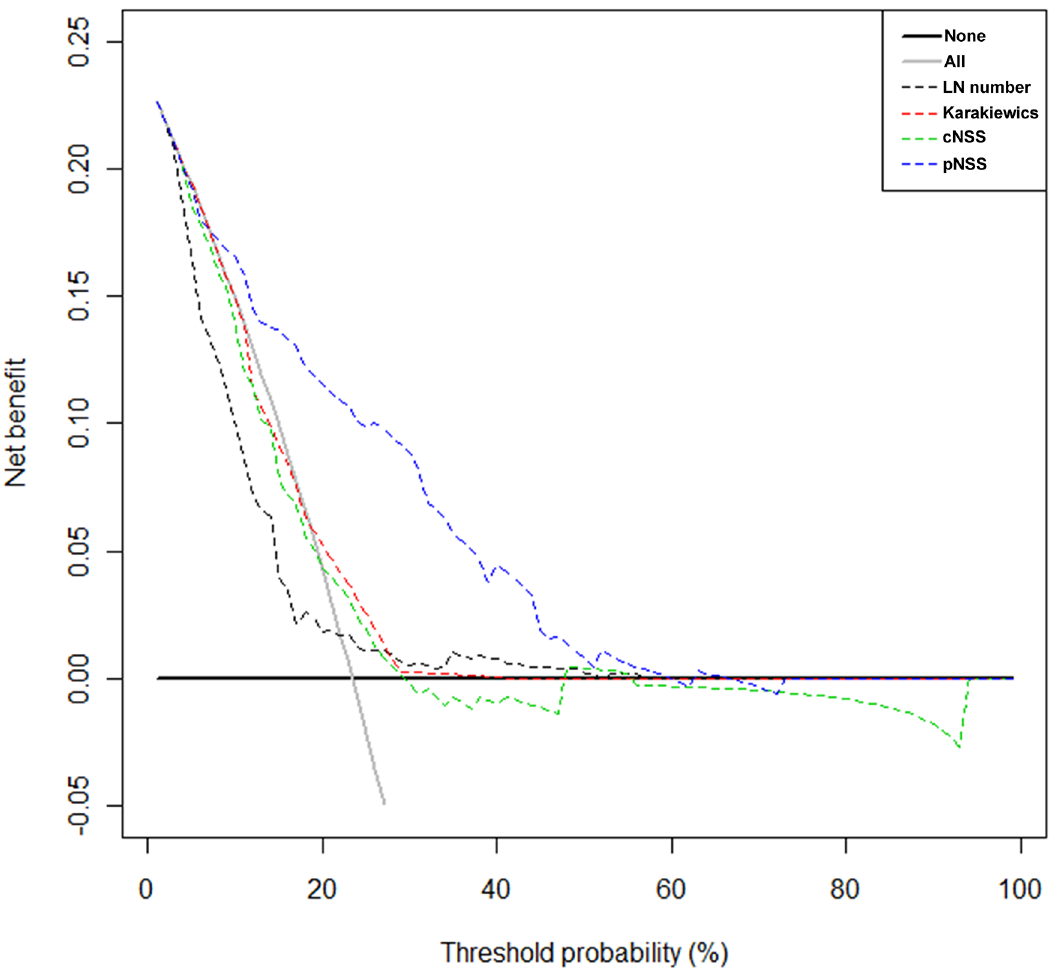
Fig 2. Decision curve analysis. Decision curve analysis. LN number = number of lymph nodes removed. Karkiewics = Karakiewicz nomogram. cNSS = clinical nodal staging score. pNSS = pathologic nodal staging score.